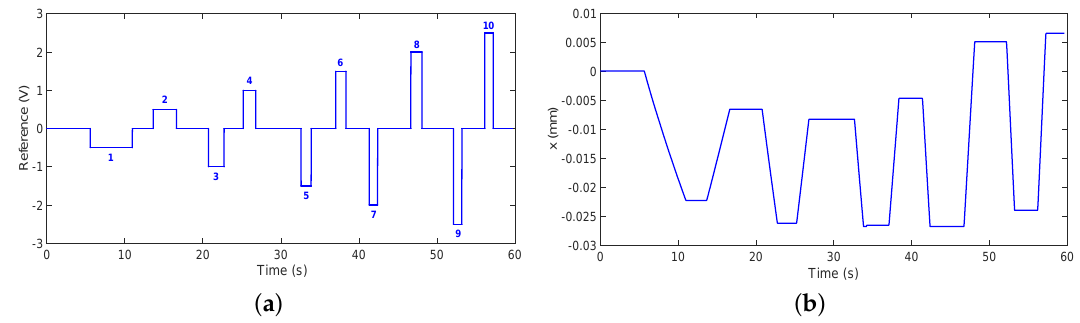
Figure 14. ( a ) applied voltage in case (b); ( b ) extension of the linear actuator in case (b).